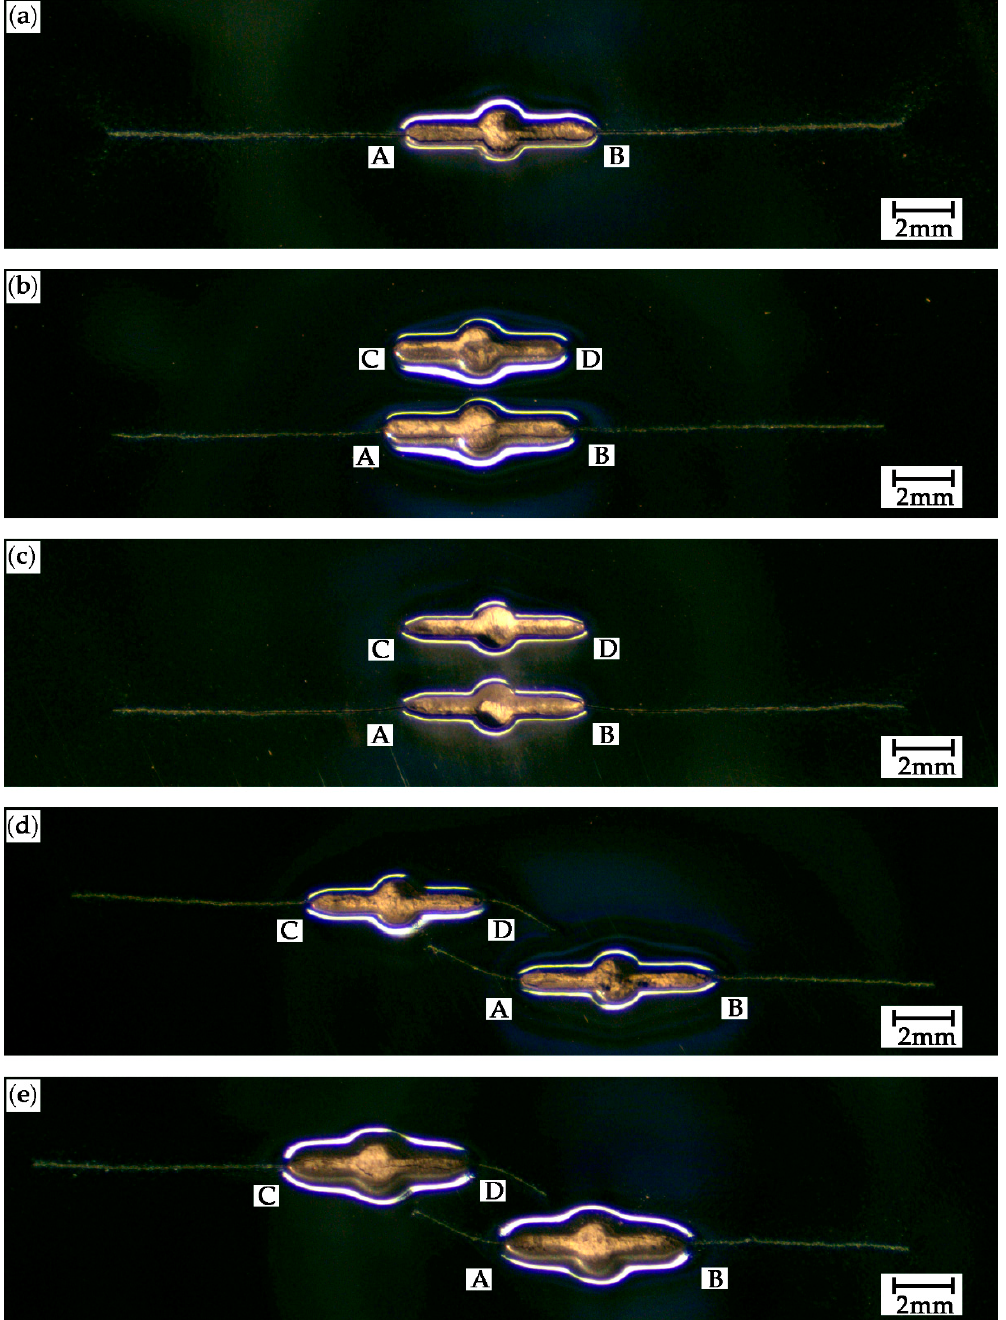
Figure 10. Crack growth paths in different specimens: ( a ) SC, ( b ) PC0.9S0, ( c ) PC1.0S0, ( d ) PC0.9S7,